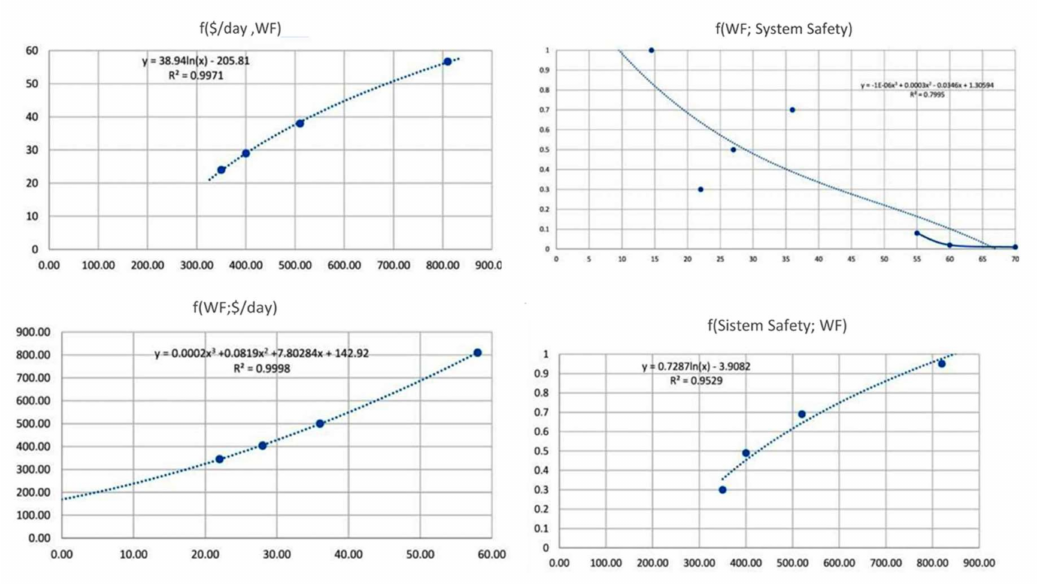
Figure 6. Prediction curve related to human